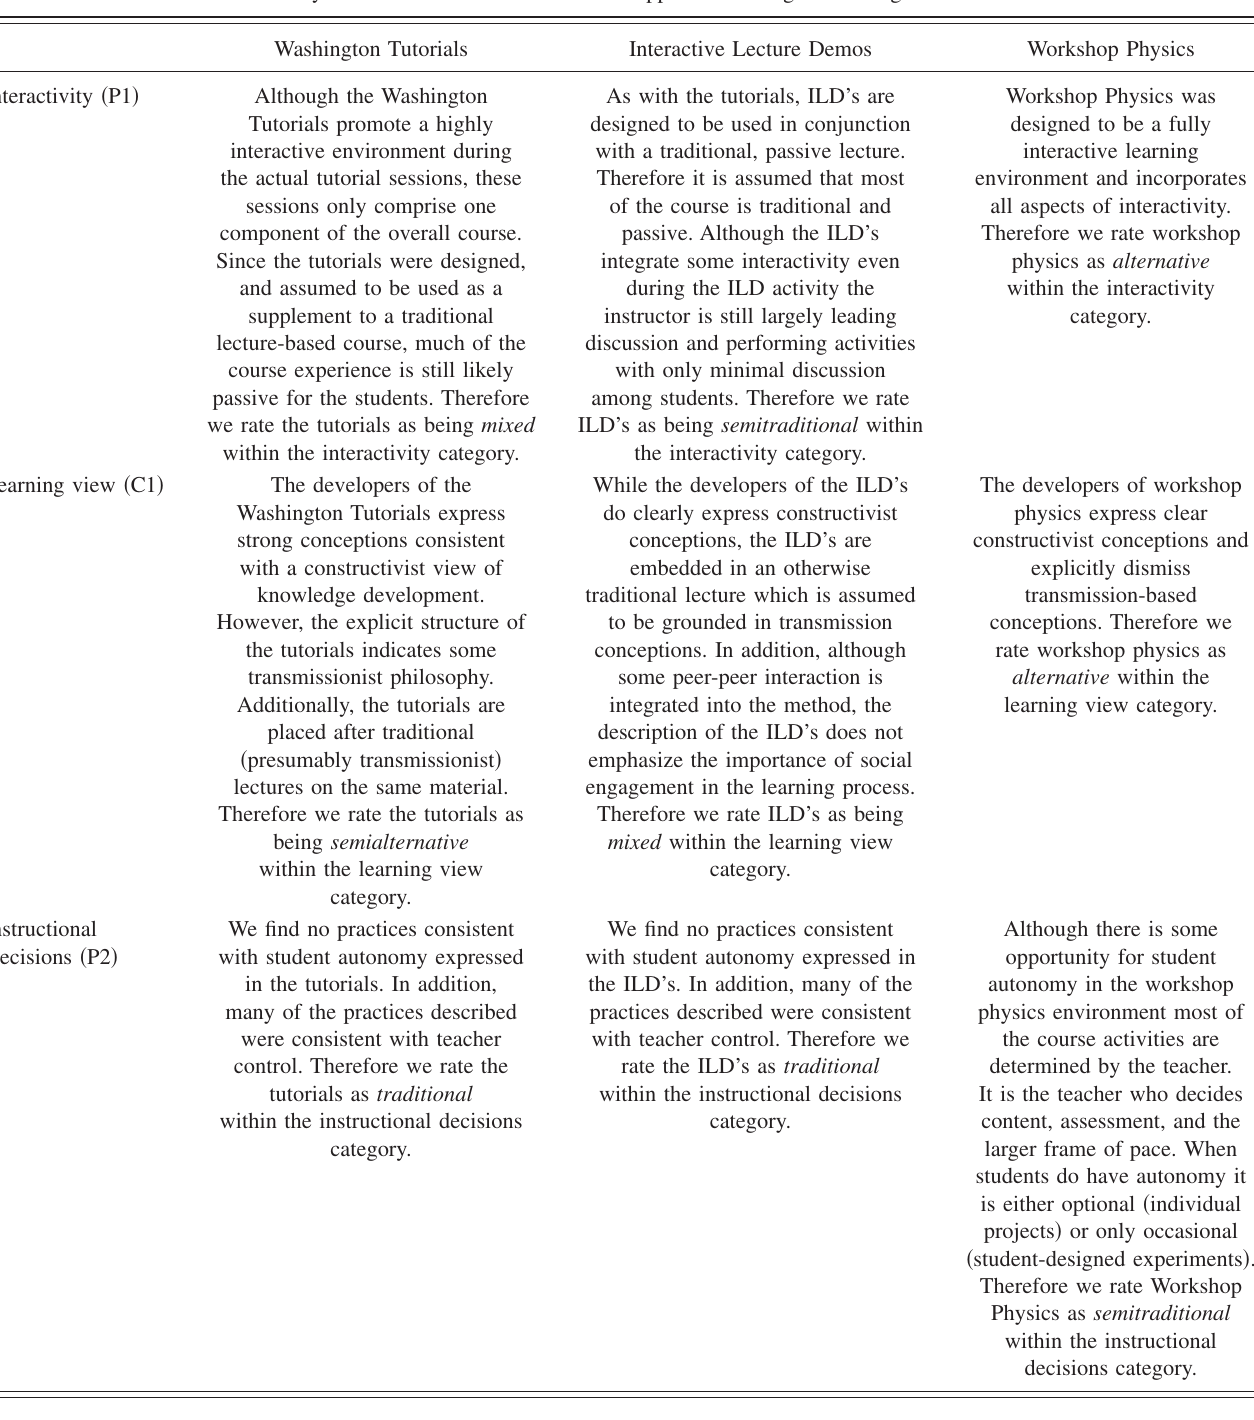
TABLE IV. Summary of three PER-based instructional approaches along three categories of the